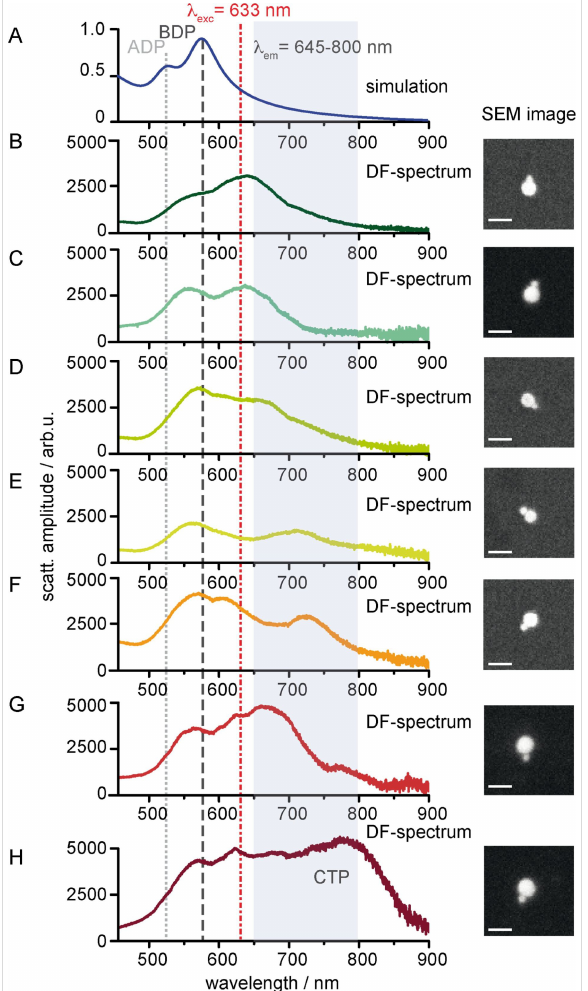
Figure 4: Far-field optical properties of individual CB[8]-mediated dumbbell dimers. (A) Scattering spectrum of a 40–80 nm AuNP dimer with a gap size of 1.0 nm calculated within the dipolar approximation limit. (B–H) Dark-field transmission spectra of individual dimers assem- bled in solution and deposited on a carbon-coated TEM grid. Insets: SEM images of the corresponding dimers (Scale bar: 100